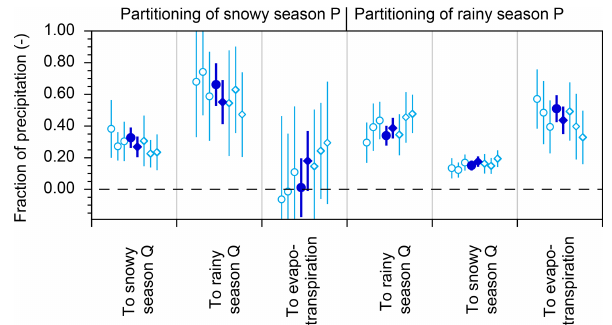
Figure 5. Seasonal partitioning of precipitation (P) into streamflow (Q) and evapotranspiration (ET), estimated from δ 18 O (circles) and δ 2 H (diamonds) from individual water years. Solid symbols show results using all available isotope measurements and long-term av- erages of P and Q water fluxes. Open symbols show results using only isotope and water flux measurements collected during indi- vidual water years (2007 through 2009, from left to right). Water years are defined from December through the following November, thus including one snowy season and the following rainy season. Seasonal partitioning estimates derived from δ 18 O and δ 2 H gener- ally agree within their standard errors, as do estimates derived from individual years of data (open symbols). Unsurprisingly, estimates derived from individual years have larger uncertainties than those derived from all available